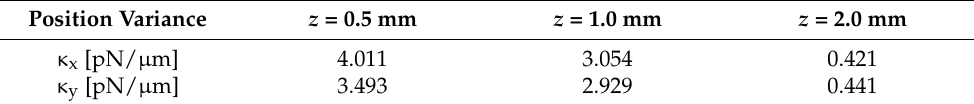
Table 2. The corresponding optical trap stiffness at different sample planes. Position